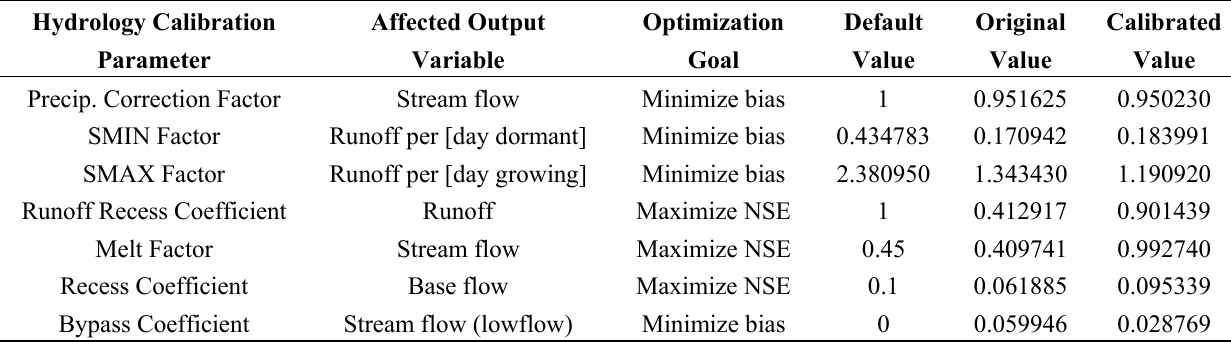
Table 2. The default, original, and calibrated values for seven calibration parameters for the Variable Source Loading Function (VSLF) model.